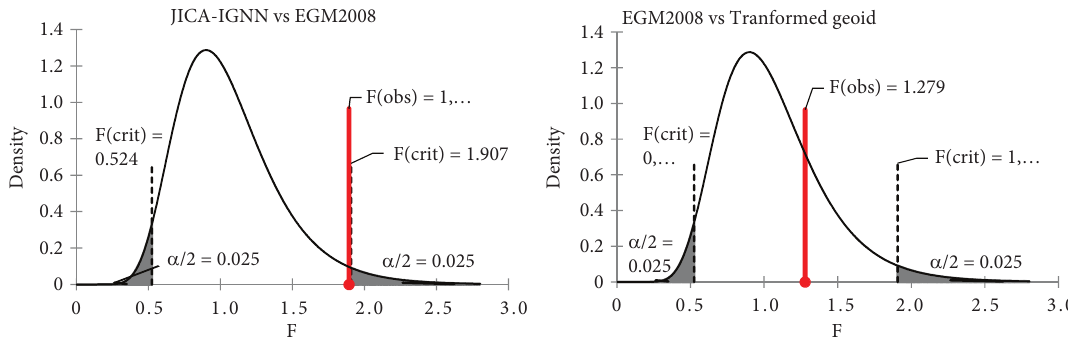
Fig. 13. Fisher-Snedecor Distributions, significance level 5%